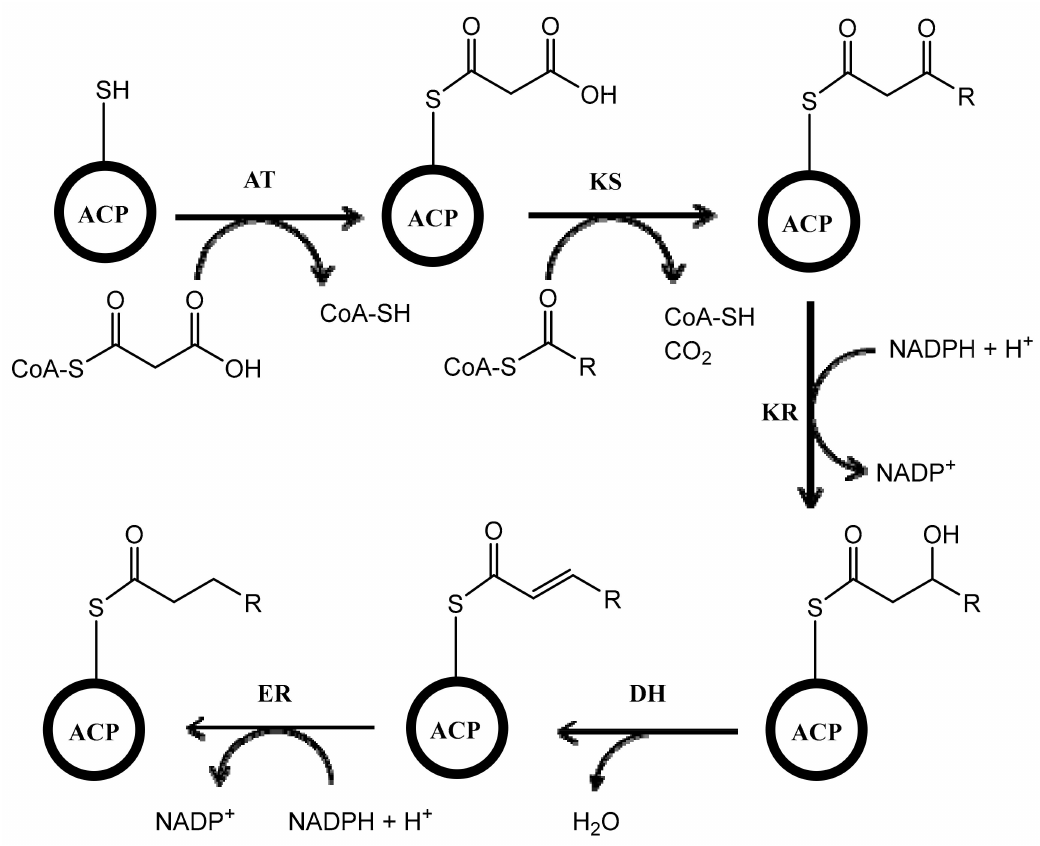
Figure 1. Scheme of the reaction occurring in polyketide synthases (PKSs). ACP, acyl carrier protein; AT, acyltransferase; KS, ketosynthase; KR, ketoreductase; DH, dehydratase; ER, enoylreductase. Adapted with permission of Portland Press, from Vance, S.; Tkachenko, O.; Thomas, B.; Bassuni, M.; Hong, H.; Nietlispach, D.; Broadhurst, W. Sticky swinging arm dynamics: studies of an acyl carrier protein domain from the mycolactone polyketide synthase. Biochem. J. 2016 , 473 , 1097–1110